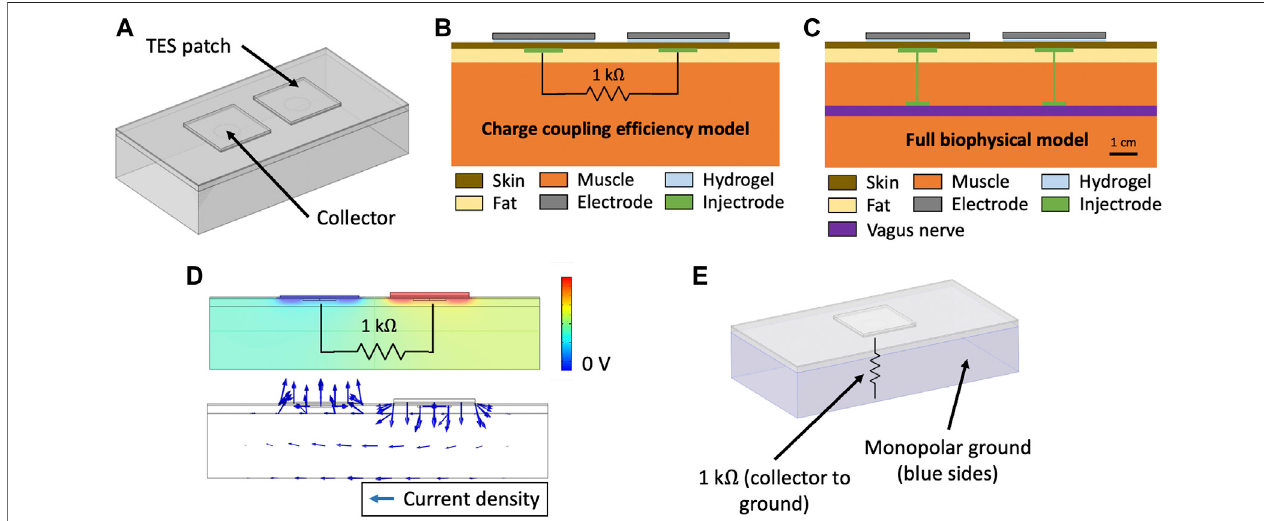
FIGURE2|(A) Three-layertissuemodel oftheInjectrodesysteminCOMSOL Multiphysics tostudytranscutaneouschargetransferfrom thesurfaceelectrodes to thesubcutaneouscollectors. (B) SchematicoftheInjectrodesystemsimpli fi edFEMmodel.Thechargecouplingef fi ciencymodelwasusedtostudythetranscutaneous charge transfer from the surface electrodes to the subcutaneous collectors. The 1 k Ω resistor was used to represent the impedance of the Injectrode connection to the deep nerve, the Injectrode-nerve interface, the nerve, and the leakage between the two Injectrode conduction paths. (C) Schematic of the Injectrode system full FEM model. The full biophysical model was used to study on- and off-target neural recruitment with the Injectrode system. (D) (Top) Electric potential solution for the standard model con fi guration at 10 kHz. Electric potential difference between the two subcutaneous collectors causes current to fl ow through the 1 k Ω resistor connecting the two collectors (Bottom) Arrows representing current density fl ow (1 k Ω resistor not shown). (E) Monopolar con fi guration of the Injectrode system to study the transcutaneous power transfer from the surface electrode to the subcutaneous Injectrode collector. Here, the 1 k Ω resistor is connected from the single collector to a 0 V ground